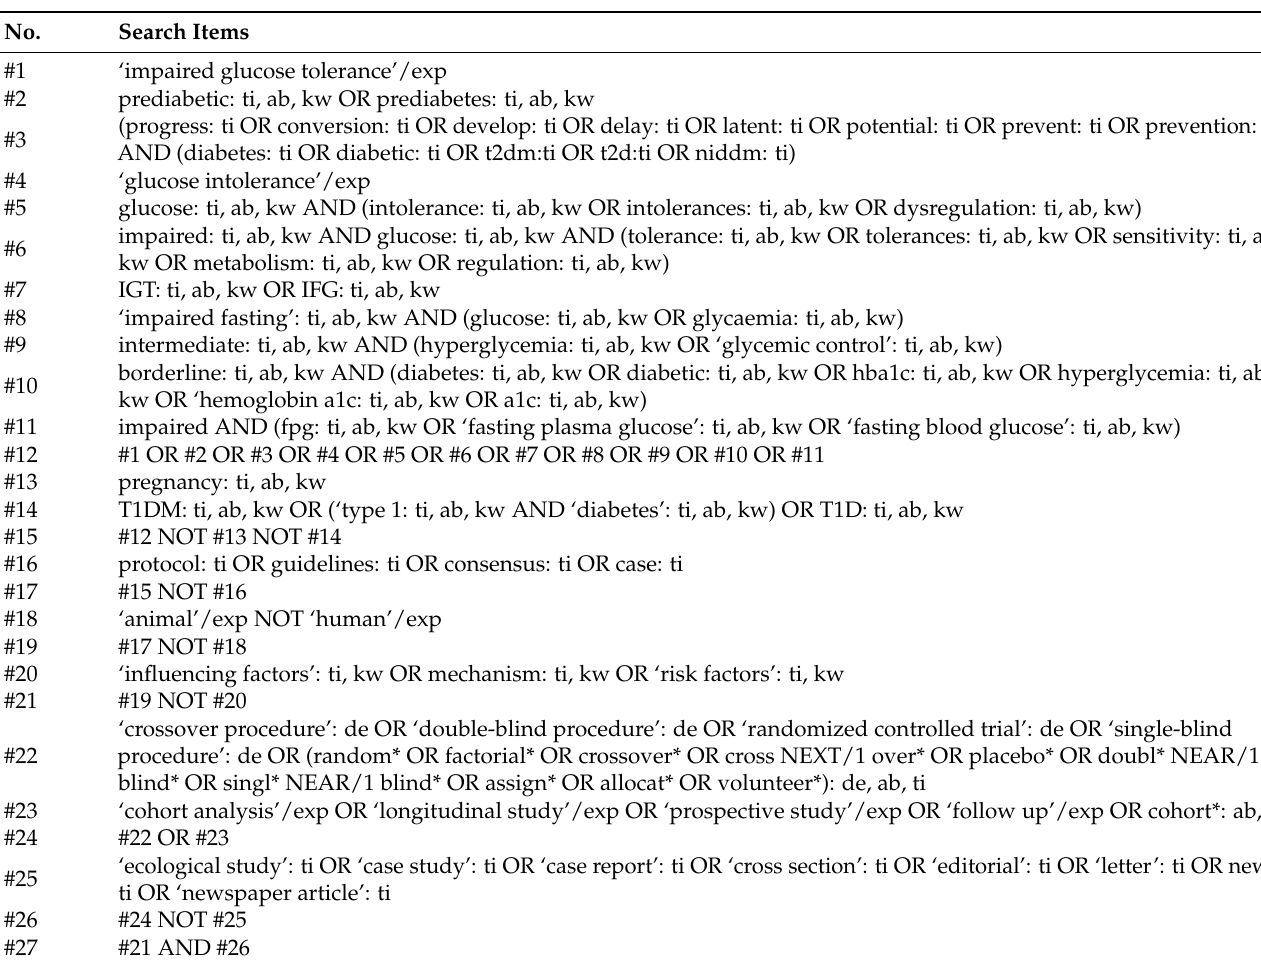
Table 2. Scoping search strategy using Embase